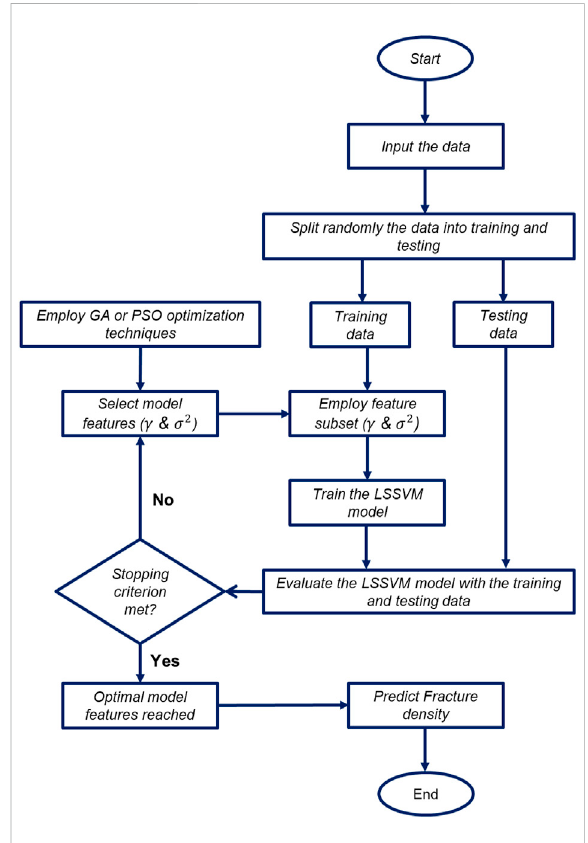
FIGURE 5 Flowchart for LSSVM-GA/PSO models used for prediction of fracture density.